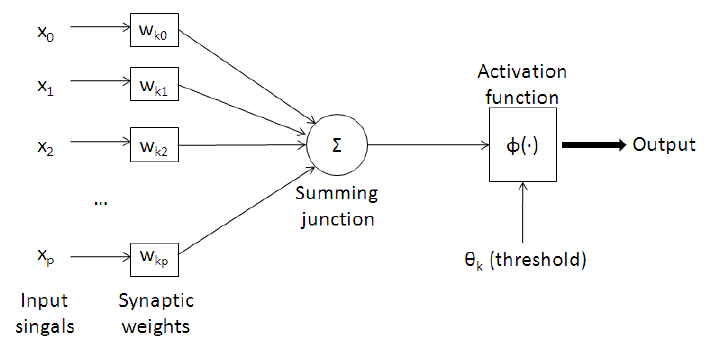
Figure 4. Mathematical model of an artificial neural network